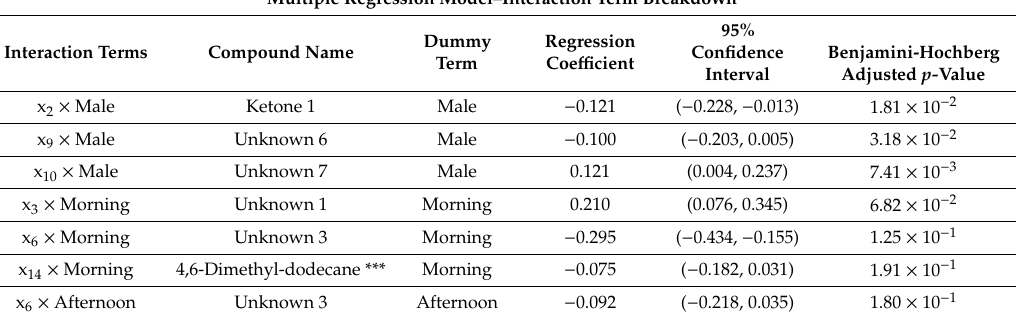
Table 2. Interaction terms used in the model have the following information provided: compound name, dummy variable, regression coe ffi cient, confidence interval, and F-statistic corrected p -value. Compounds denoted with *** fell within 6% of NIST reported non-polar